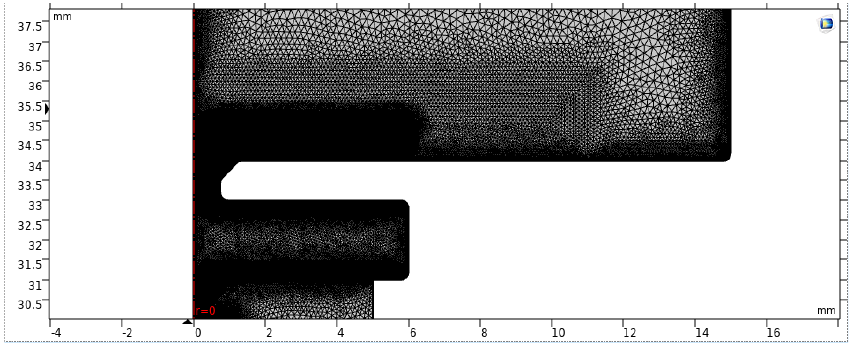
Figure 5. Mesh generation of hollow cathode model.